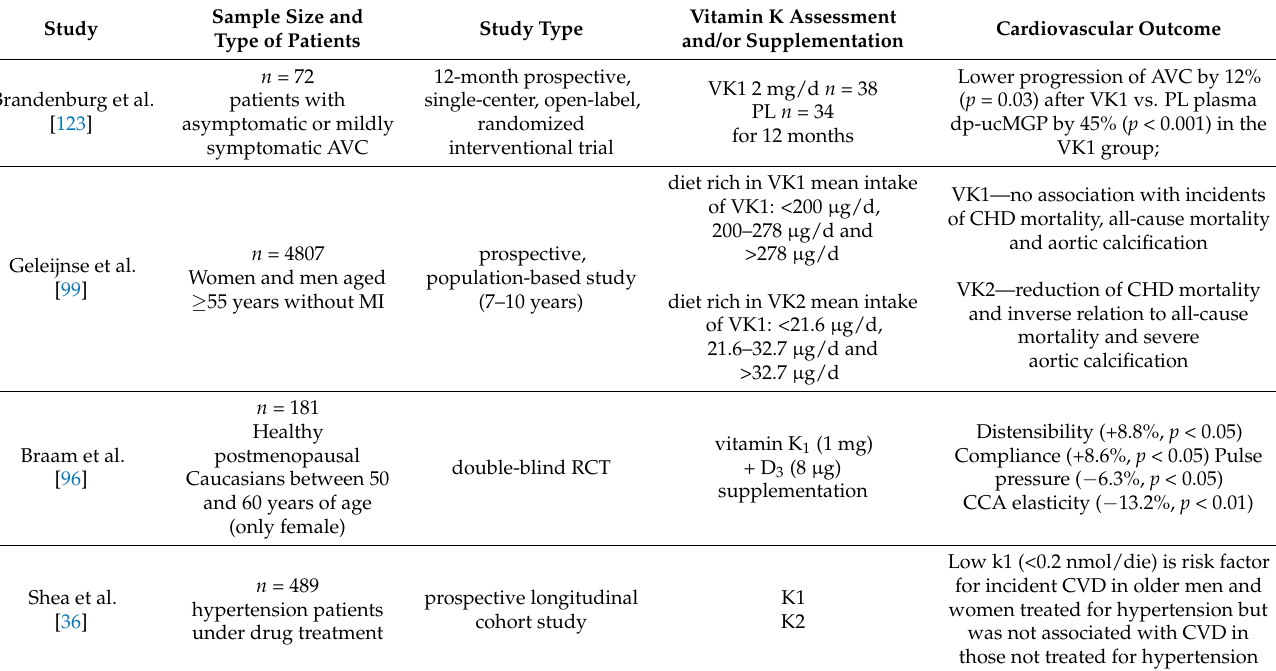
Table 1. Effects of supplementation of vitamin K and cardiovascular